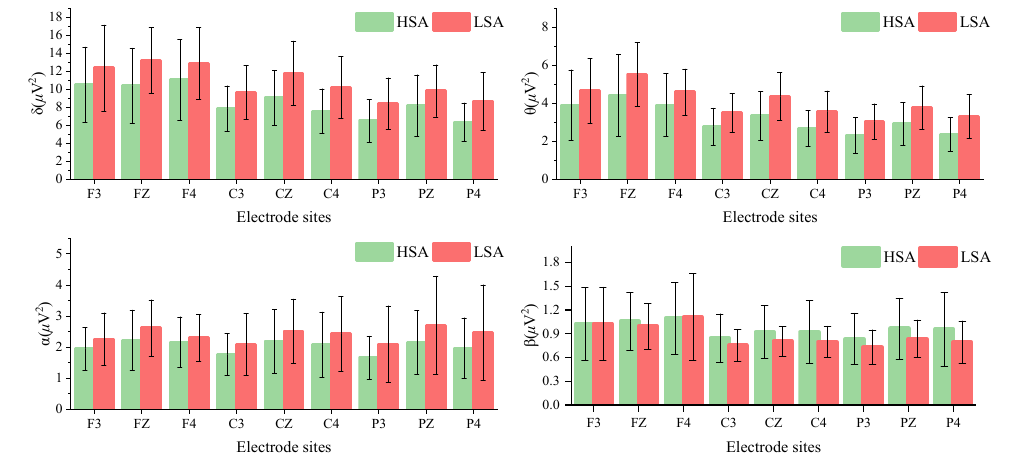
Figure 3. Absolute power for the two SA groups.